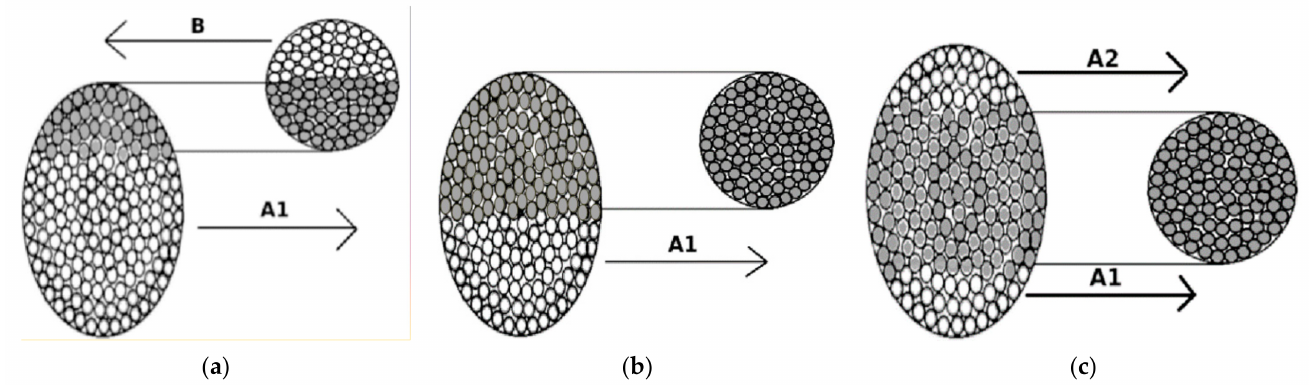
Figure 1. Schematic representation of the interaction of nuclei of various degrees of centrality: ( a ) peripheral interaction; ( b ) weakly central interaction; ( c ) strongly central interaction. The nucleon- participants are marked in darker color. The light color indicates spectator nucleons that form projectile-nucleus (A1, A2) and target-nucleus